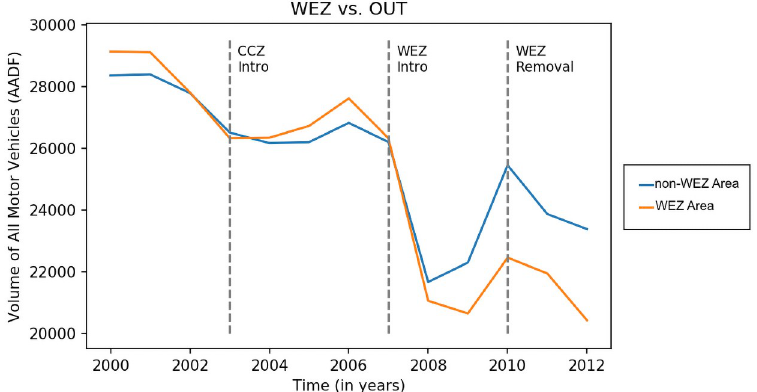
Fig 2. Annual average traffic flows in Greater London between 2000 and 2012 (source: AADF, DfT).